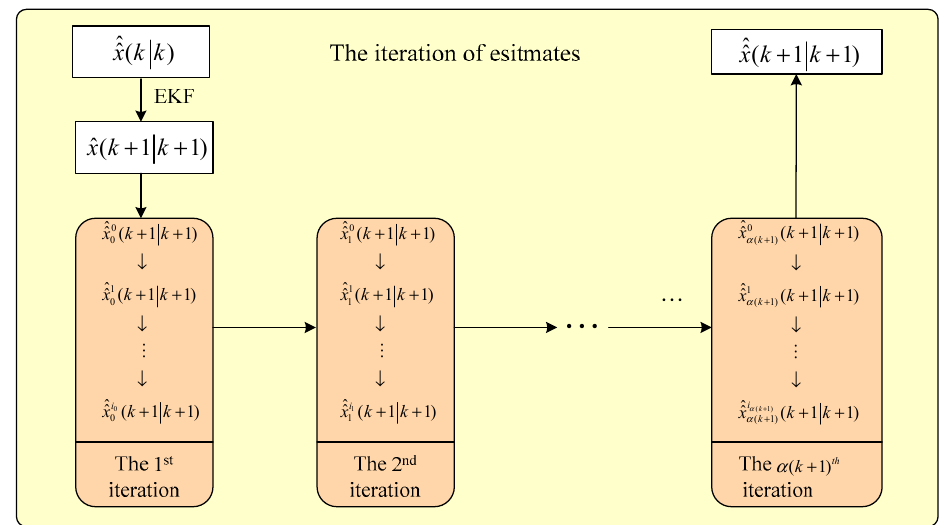
Figure 1. Flowchart of the iterative computational process of the estimates.